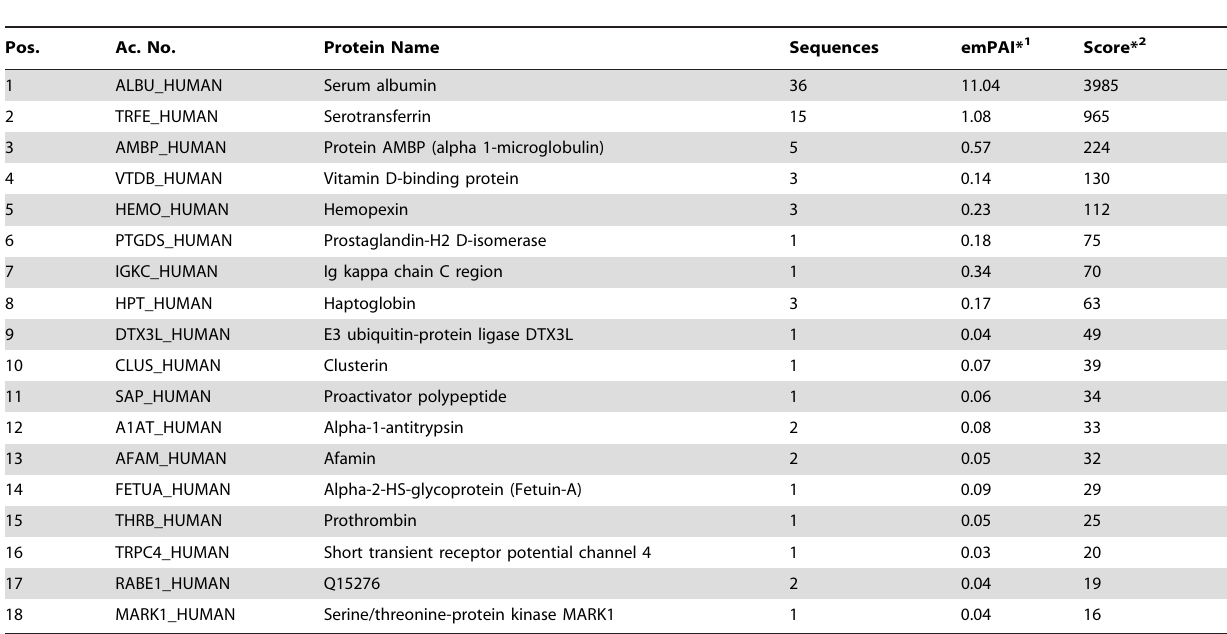
Table 2. Liquid chromatography–tandem mass spectrometer (LC/MS-MS) of samples from the patients with A3G3 and the search result through NCBInr and Swiss-Prot database performed by Mascot.